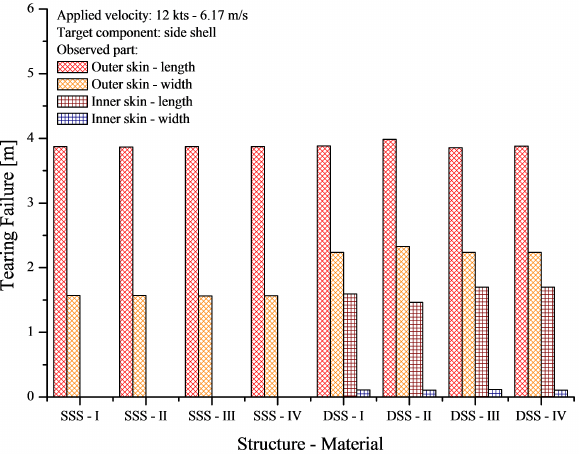
Figure 8: Energy behaviour in virtual experiment for all designed collision